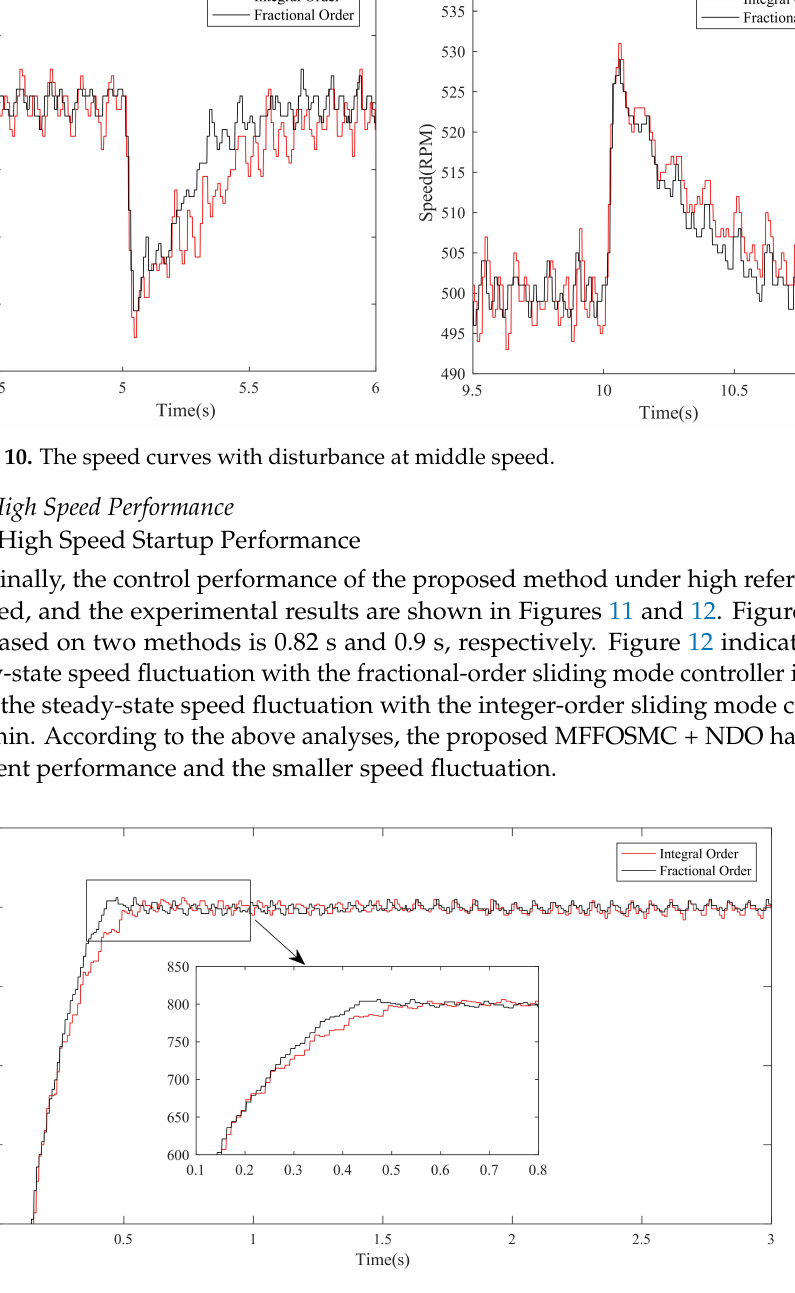
Figure 11. The response curves at high